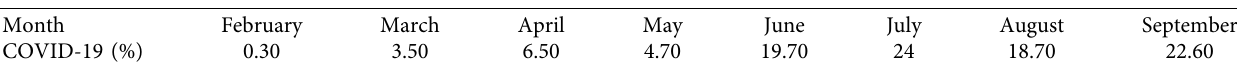
Table 2: Distribution of 53 554 COVID-19 cases in Fars province, Iran, February 18–September 30,